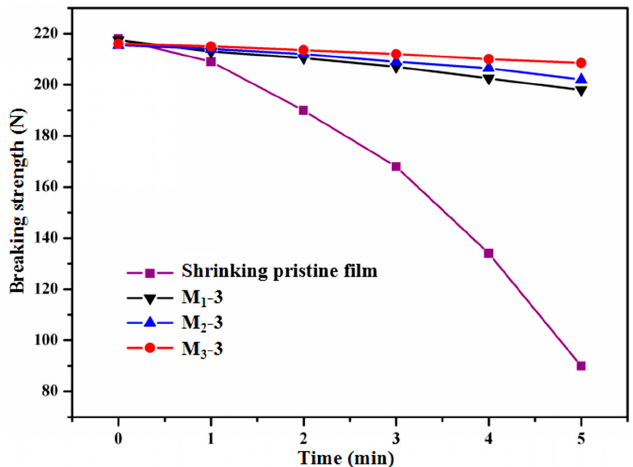
ff erent UV irradiation